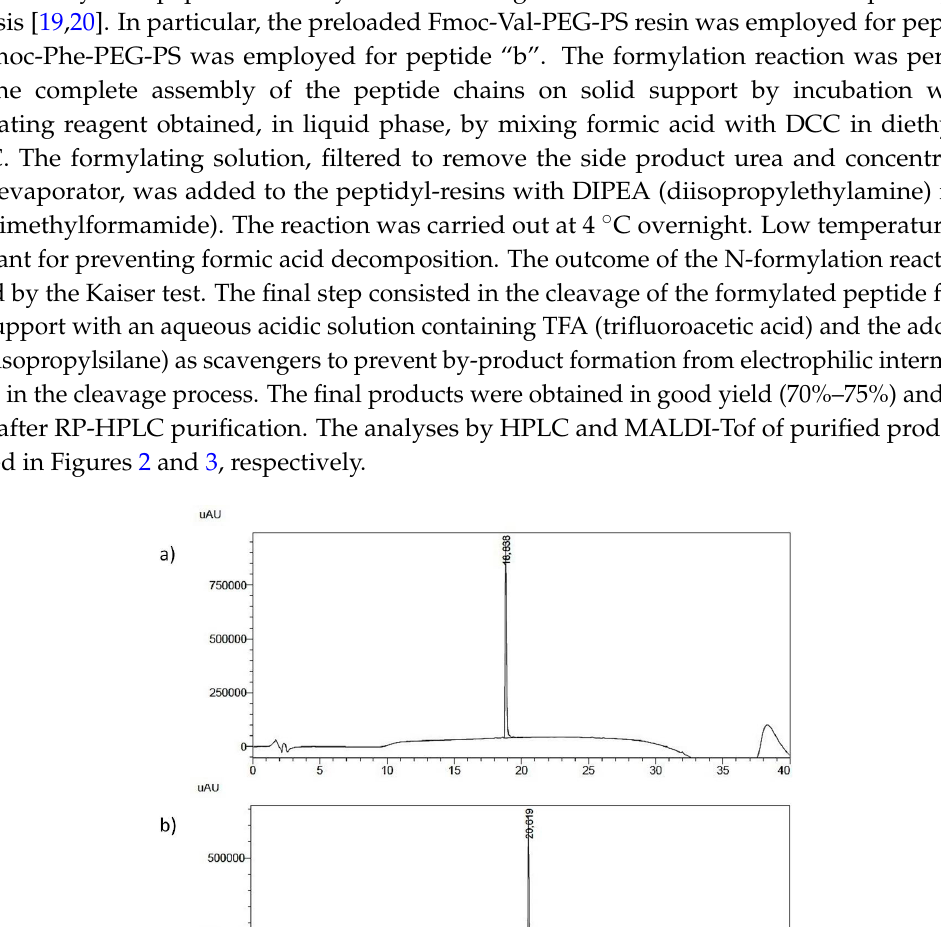
Figure 2. HPLC elution profile of purified peptides ( a , b ).